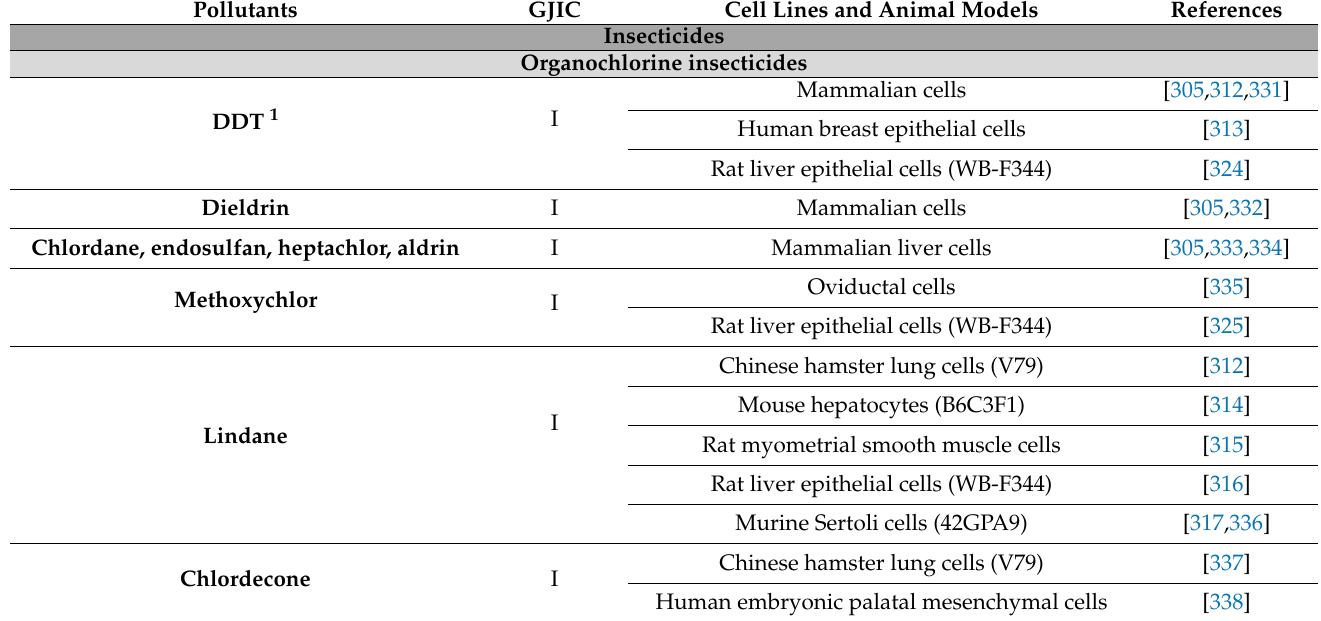
Table 3. Effects of environmental chemical pollutants on gap-junctional intercellular communication of various mammalian cell types. Abbreviations: GJIC, gap-junctional intercellular communication; I, inhibition of GJIC; A, activation of GJIC. The names of the cell lines tested are indicated between